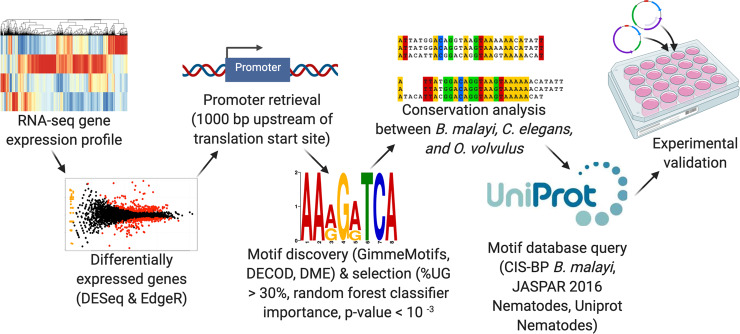
Workflow for promoter motif identification.The six main steps for motif discovery were: (1) generation of an RNA-seq profile; (2) determination of up-regulated genes for every pairwise comparison using DESeq2 (FDR<0.01) and EdgeR (adjusted P-value<0.01); (3) promoter retrieval: 1000 bp upstream of the translation start site; (4) ensemble motif discovery using GimmeMotifs (Homer, AMD, BioProspector, MDmodule, MEME, Weeder, GADEM, and Improbizer), DECOD, DME, and selection of enriched motifs: %UG > 30% and random forest classifier feature importance and over-representation p-value < 10−3; (5) TFBS conservation analysis between B. malayi, C. elegans, and O. volvulus; and (6) motif database query: CIS-BP B. malayi, JASPAR 2016 Nematodes, Uniprot Nematodes. Finally, a subset of those identified motifs were experimentally validated.